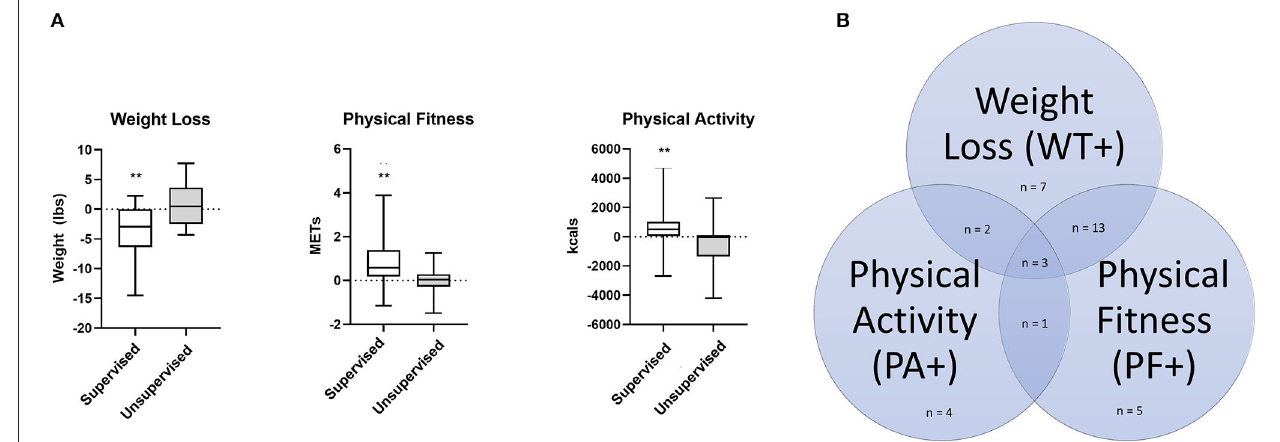
FIGURE 2 | (A) Bar graphs showing in weight loss, physical fitness, and physical activity in patients engaged in supervised ( n = 36) and unsupervised ( n = 16) programs. ** P -value ≤ 0.01. For supervised group: weight loss, p = 0.0029; METs change, p = 0.0025; kcal change, p = 0.0111; Mann-Whitney U Test. (B) Venn diagram showing the number of patients who met the pre-defined criteria for success: Weight loss ≥ 5 pounds, increase in physical activity of greater or equal to 1,000 kcals per week, and/or improvement in metabolic equivalents of greater or equal to 0.5 METs. Patients who met at least one criteria were deemed successful.